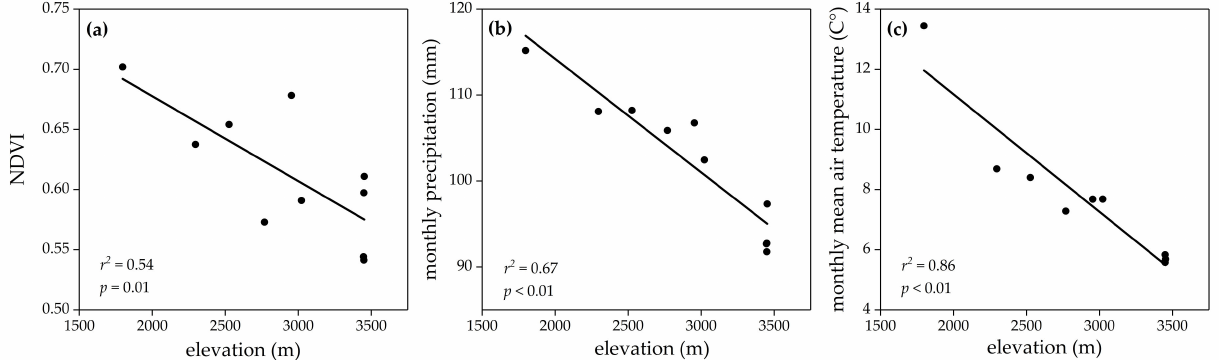
Figure 2. Variation in environmental variables along an elevation gradient on the eastern margin of the Qinghai–Tibetan Plateau. ( a ) Normalized difference vegetation index (NDVI); ( b ) monthly precipitation; ( c ) monthly mean air